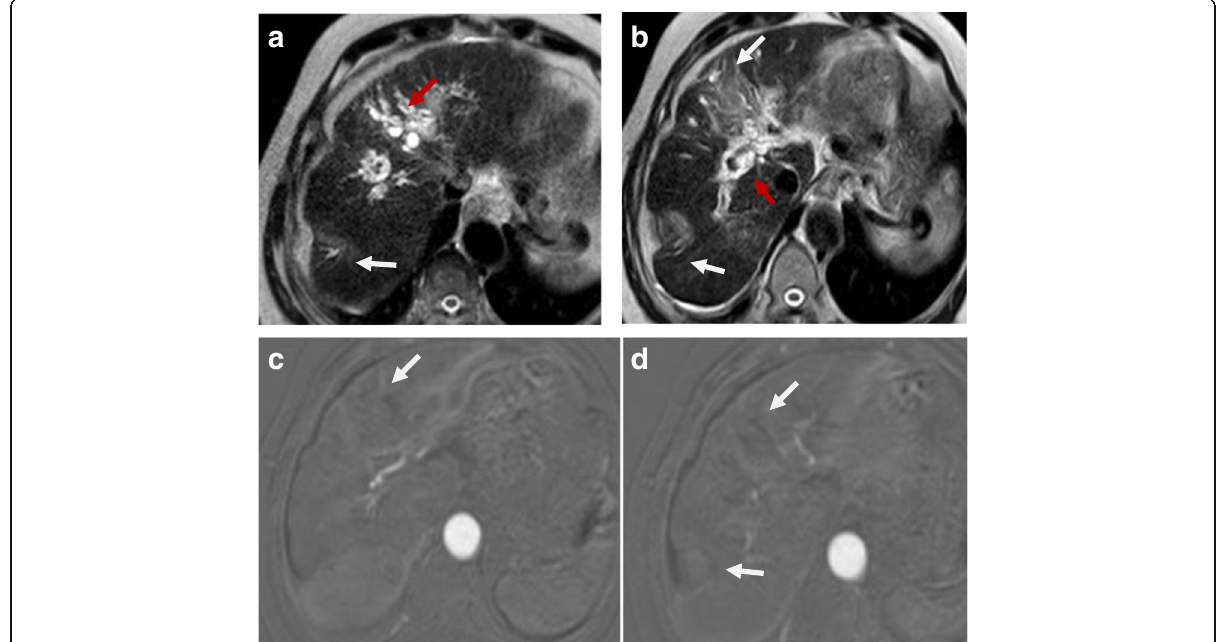
Fig. 8 Hepatic focal lesions after TACE. a , b T2-WI shows two well-defined HFLs of an intermediate to high signal (white arrows) with central biliary dilatation (red arrow). c , d Subtracted T1-WI arterial phase shows no enhancement of the lesions. Overall post-treatment assessment is LR- TR nonviable with post-therapy biliary